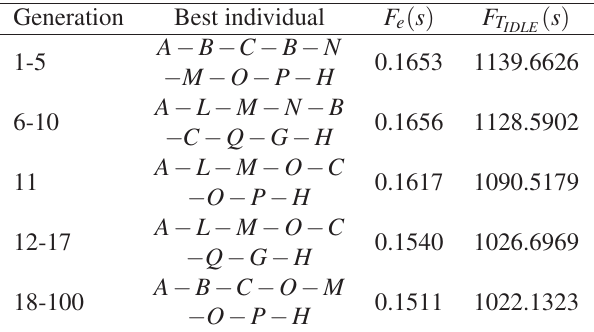
Table 1. Details of Best Individuals in Each Generation Generation